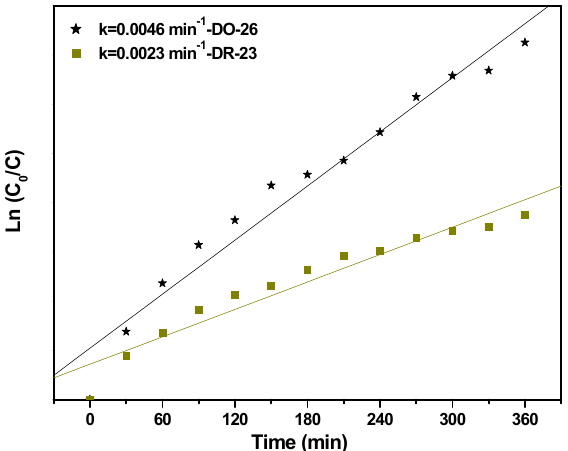
Figure 9. The first-order kinetic plots for the photocatalytic degradation of Direct Orange 26 or Direct Red 23 using BiGdO 3 as a photocatalyst.